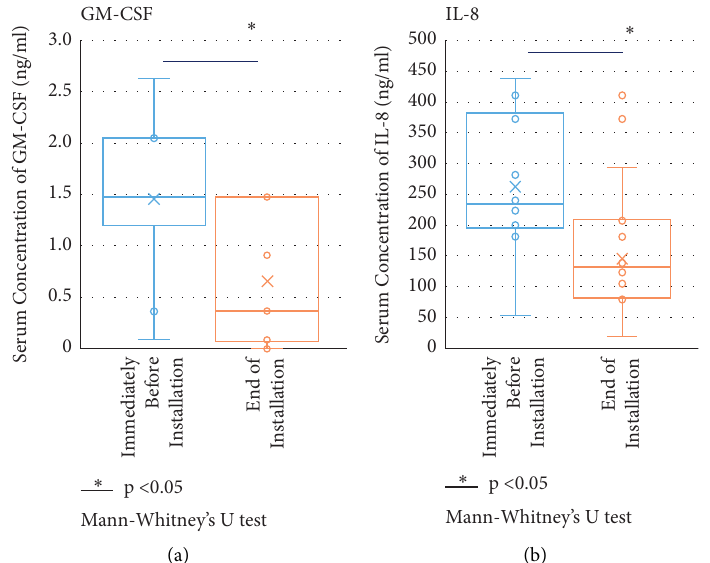
Figure 6: Examination of 29 cytokines from blood collections just before CCSNOP exposure and immediately before removal of CCSNOP panel (blood collections # 4 and 5, in Figure 2). GM-CSF (panel (a)) and IL8 (panel (b)) showed significant differences as determined by the Mann–Whitney U test ( P < 0 . 05). Values for both cytokines were higher just before CCSNOP installation compared to those immediately prior to CCSNOP